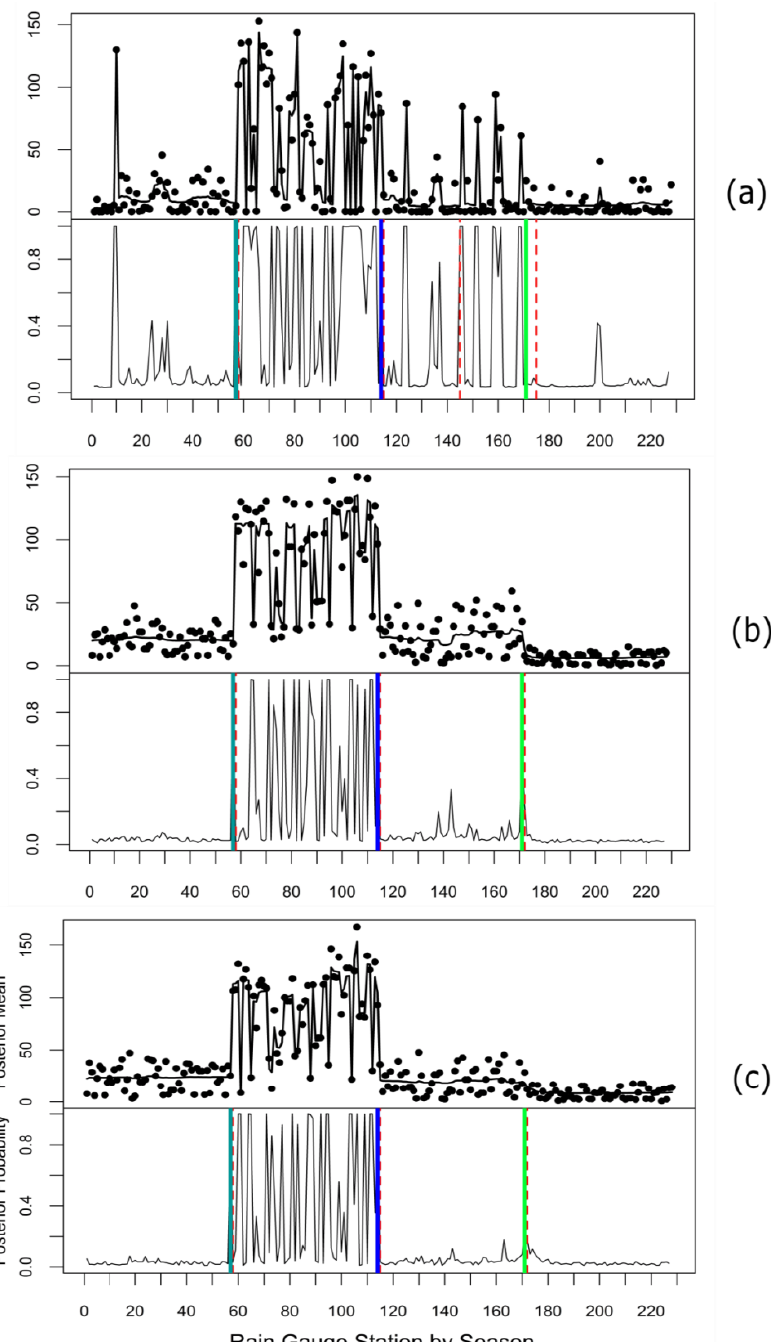
Figure 10. Bayesian change point (bcp) and nonparametric approach for multiple change point analysis (ecp) results for 2016 (seasonal accumulation) for ( a ) OBSERVED, ( b ) TRMM, and ( c ) GPM. The solid lines show the original seasonal partitioning season (the teal color indicates when DJF (winter) ends and spring (MAM) begins, the blue color when spring ends and summer (JJA) begins, and green when summer ends and autumn (SON) begins). The dash red lines show the change points derived using both bcp and ecp. The X -axis indicates the total number of rain-gauge stations (57) used, meaning each partition (solid line and season) has 57 stations.